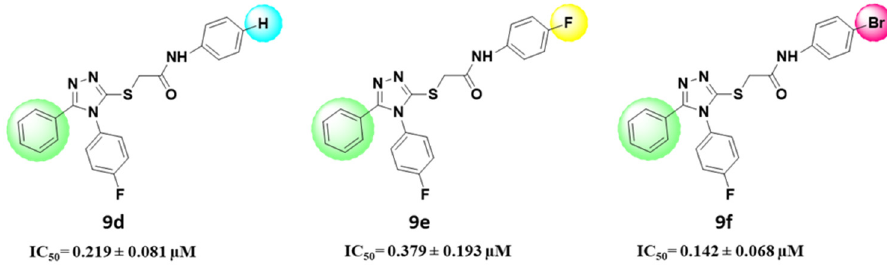
Figure 2. Structural activity relationship of 9e , 9e , and 9f .